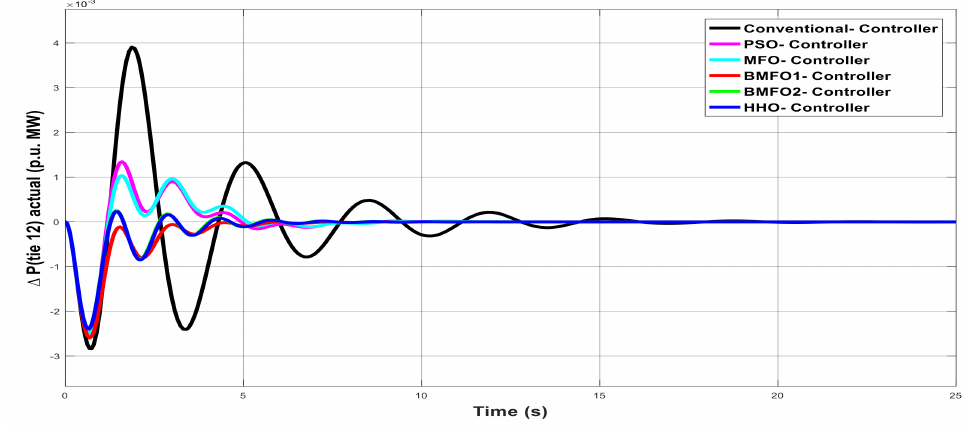
Figure 5. Deviation in actual tie-line power flow with various controllers under unilateral contract.